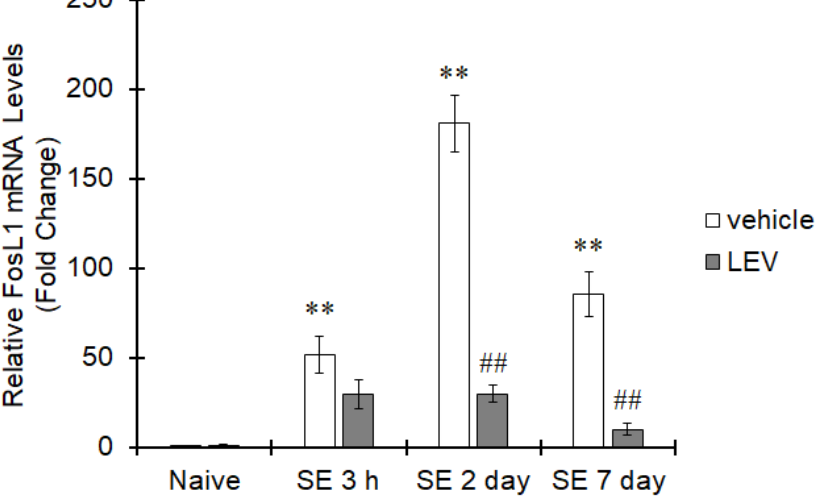
Figure 3. Involvement of FosL1 in microglial inflammatory reaction. Control or FosL1 siRNA was transfected into BV-2 cells with a ramified-like morphology. The cells were pretreated with LEV for 20 min, and LPS was subsequently added for 24 h. The expression of FosL1 ( A ), TNF α and IL-1 β ( B ) were measured by real-time PCR. The values are presented as the mean ± S.E. of 5 separate experiments. The data were analyzed using ANOVA followed by Student ′ s t -test. ** p < 0.01 vs. the untreated group and ## p < 0.01 vs. the LPS-treated group.